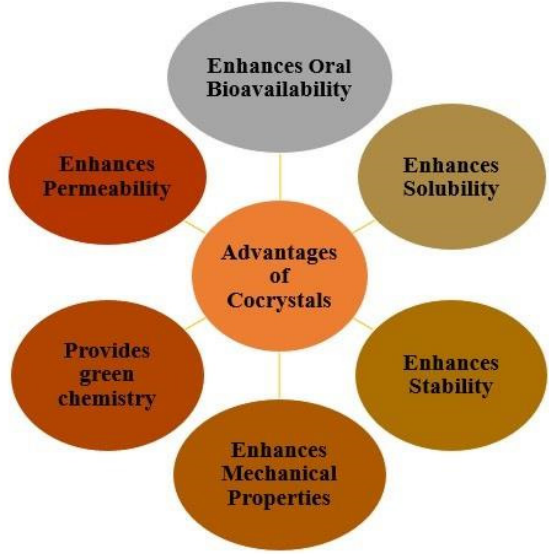
Figure 3. Advantages of pharmaceutical cocrystals.